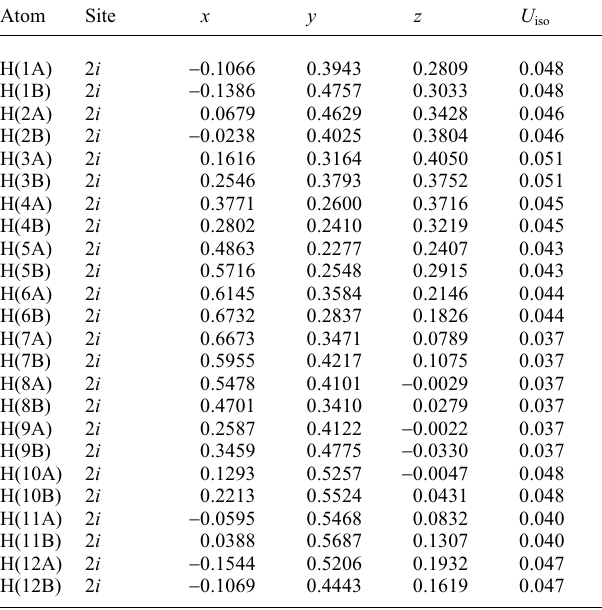
Table 2. Atomic coordinates and displacement parameters (in Å 2 )